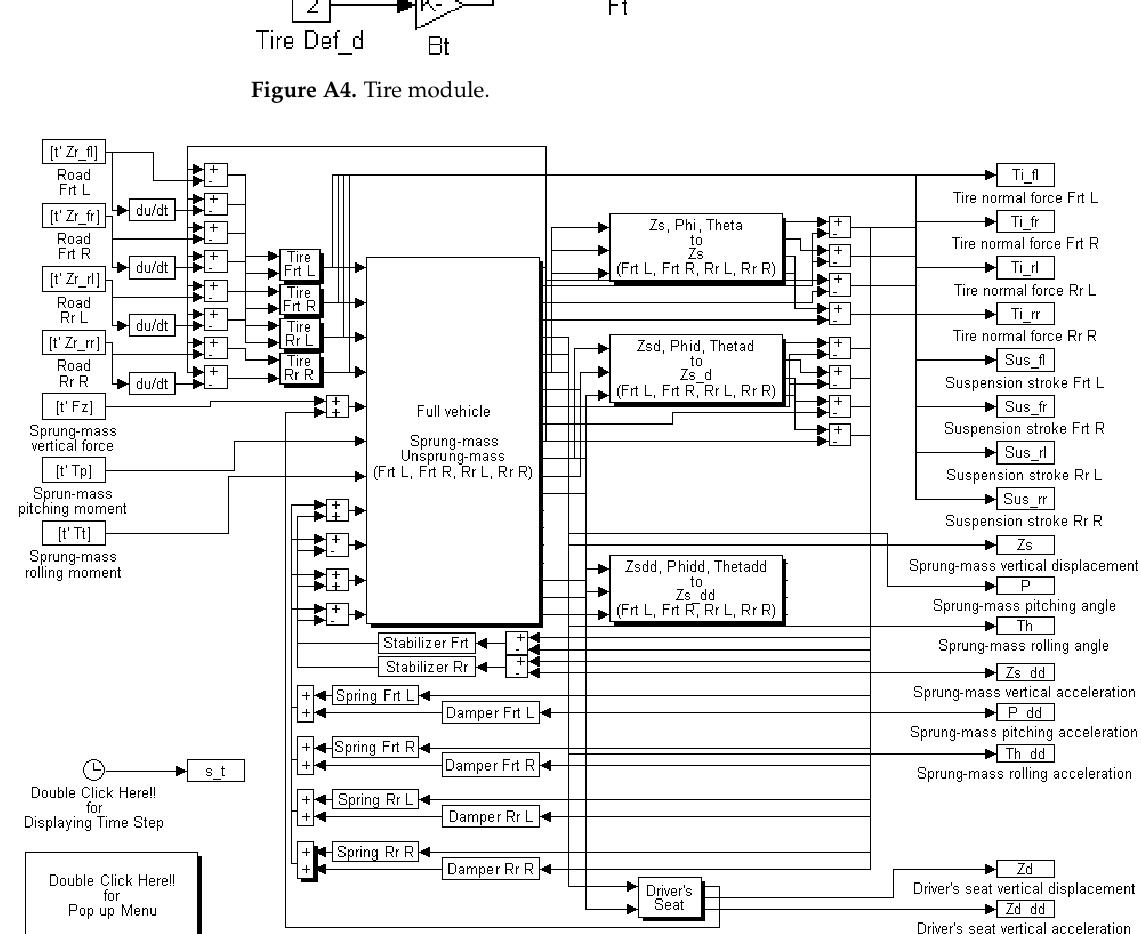
Figure A5. Full car model using the simulation modules.